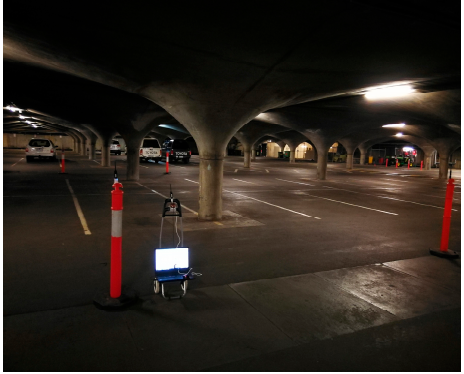
Figure 6. Test site in the underground garage.